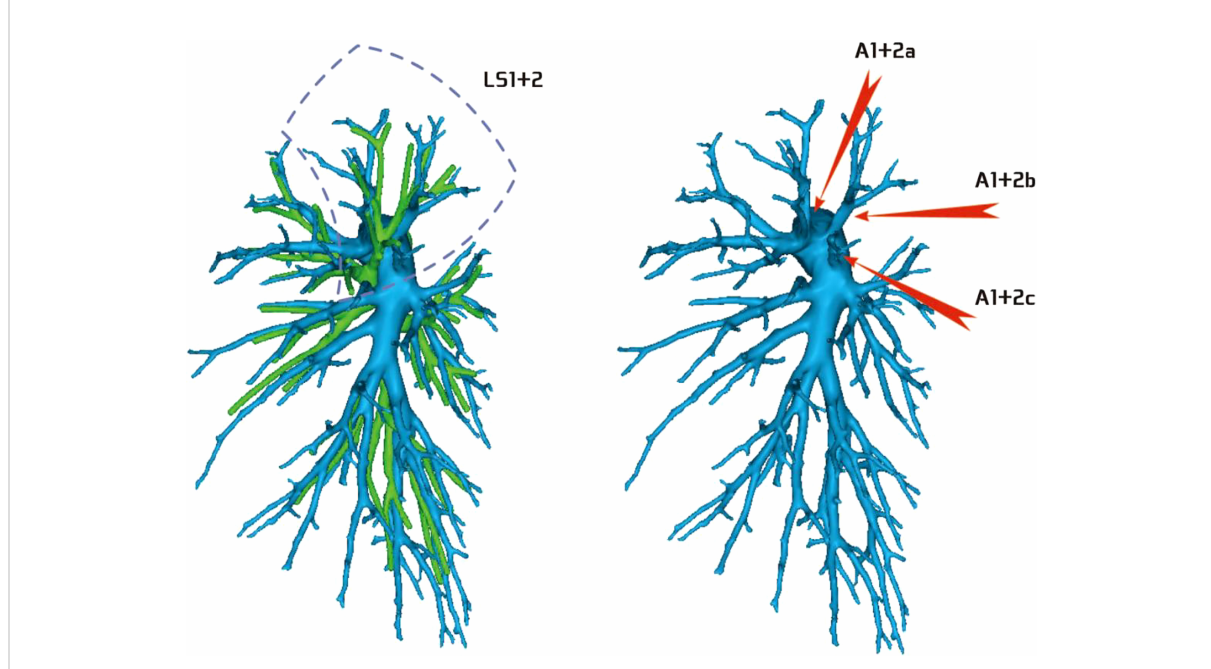
FIGURE 4 Type I: Dotted line is the LS1 + 2 area, and A(1 + 2)a, A(1 + 2)b, and A(1 + 2)c are separate